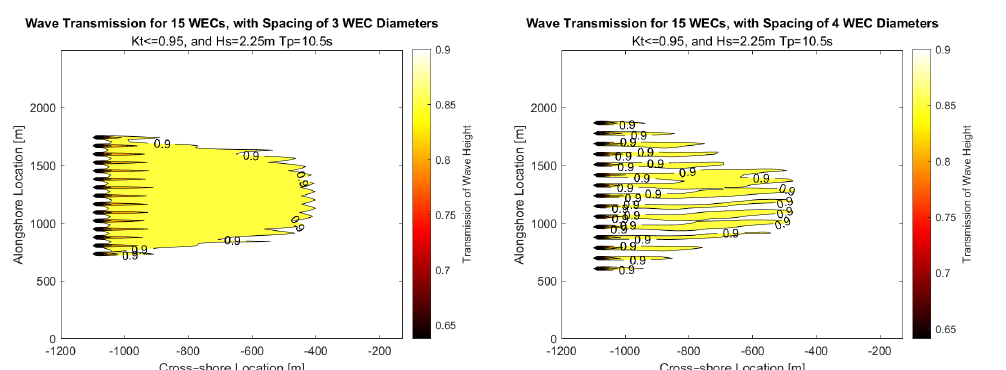
Figure 14. Normalized wave transmission magnitude and extent of wave transmission influence in the lee of the 15 WEC array. The color bar shows the percentage of transmission in the wake